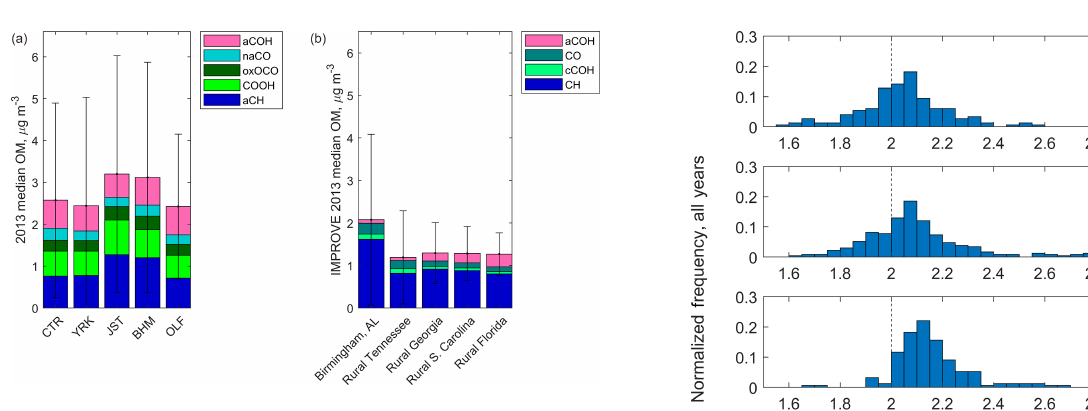
Figure 4. Bar plots of OM median concentrations for all sites, 2013, using the current models and SEARCH ambient samples (left), as compared to previous work (applied by Kamruzzaman et al., 2018, and compared to IMPROVE network samples, using models con- structed by Ruthenburg et al., 2014). Error bars represent the in- terquartile ranges of the total OM concentrations.